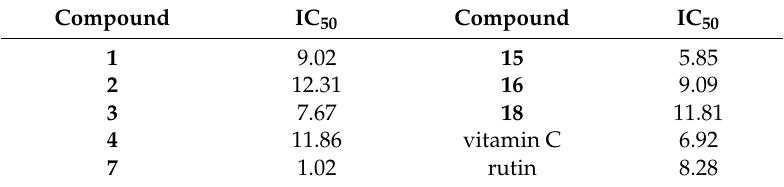
Table 3. DPPH radical-scavenging activity of the compounds from B. rynchopetera (IC 50 , µ g/mL). Compound IC